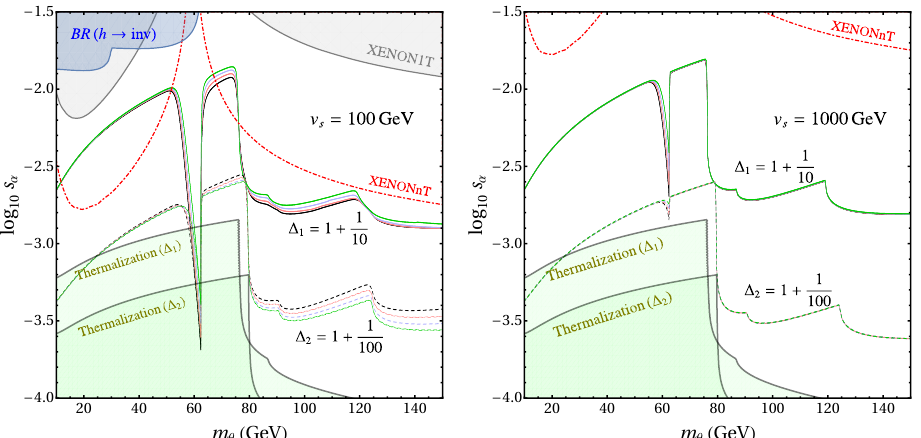
Figure 6. Curves for the relic abundance in the ρ resonance for different values of the mass splitting in eq. (4.8), ∆ = 1 + 1 / 10 (solid), ∆ = 1 + 1 / 100 (dashed) and v = 10 2 , 10 3 GeV (left, 1 2 s right). Experimental constraints from invisible Higgs decays (blue), XENON1T experiment [58] (gray), the projection for XENONnT [65] (red dot-dashed line) and the thermalization condition (green) are shown. Same color code for the minimal models as in figure 4.